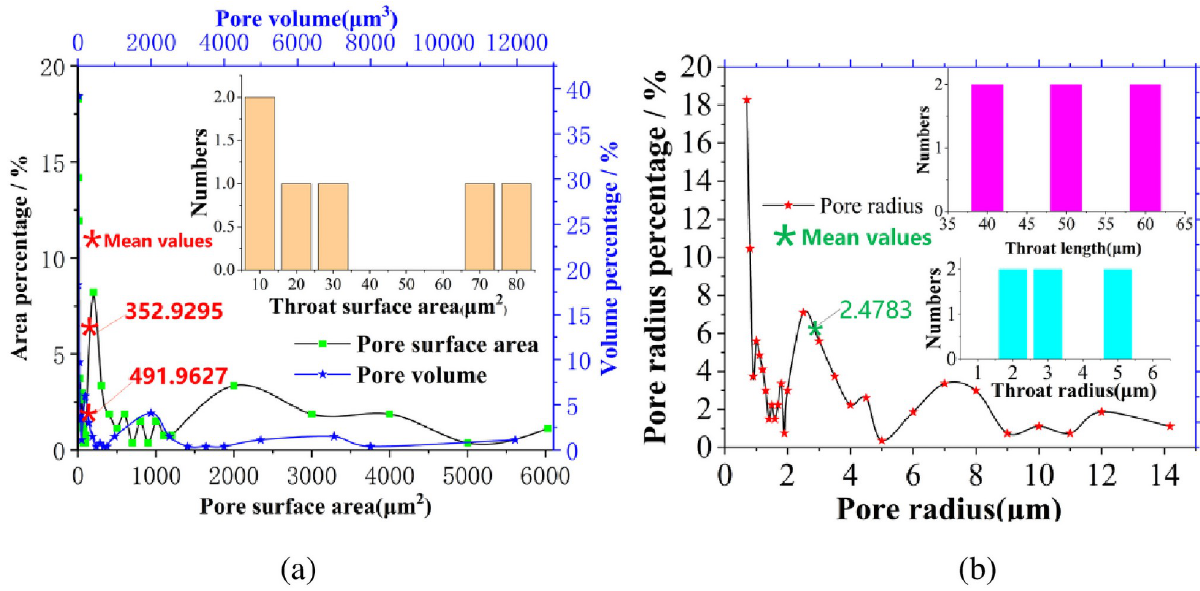
Fig 6. Statistics of pore-throat quantitative parameters in the pore network